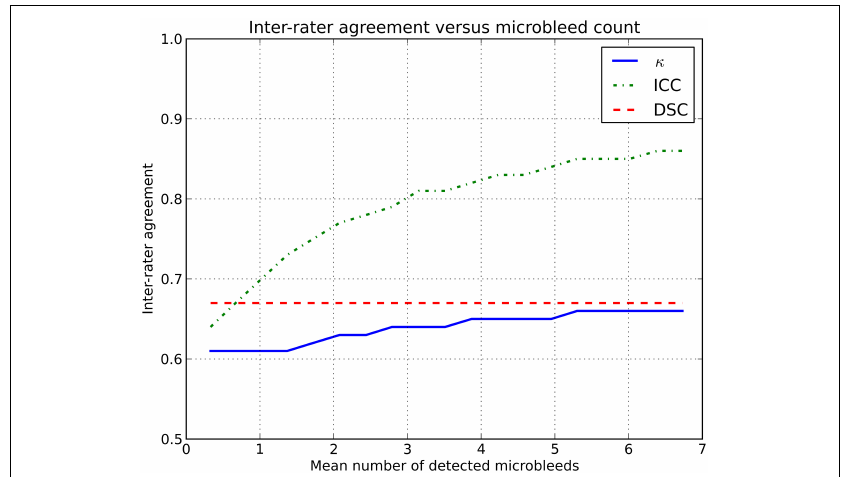
FIGURE 1 | Inter-rater agreement in simulations where two raters (with fixed sensitivities of 75 and 60%) rate microbleeds in different datasets with an increasing number of